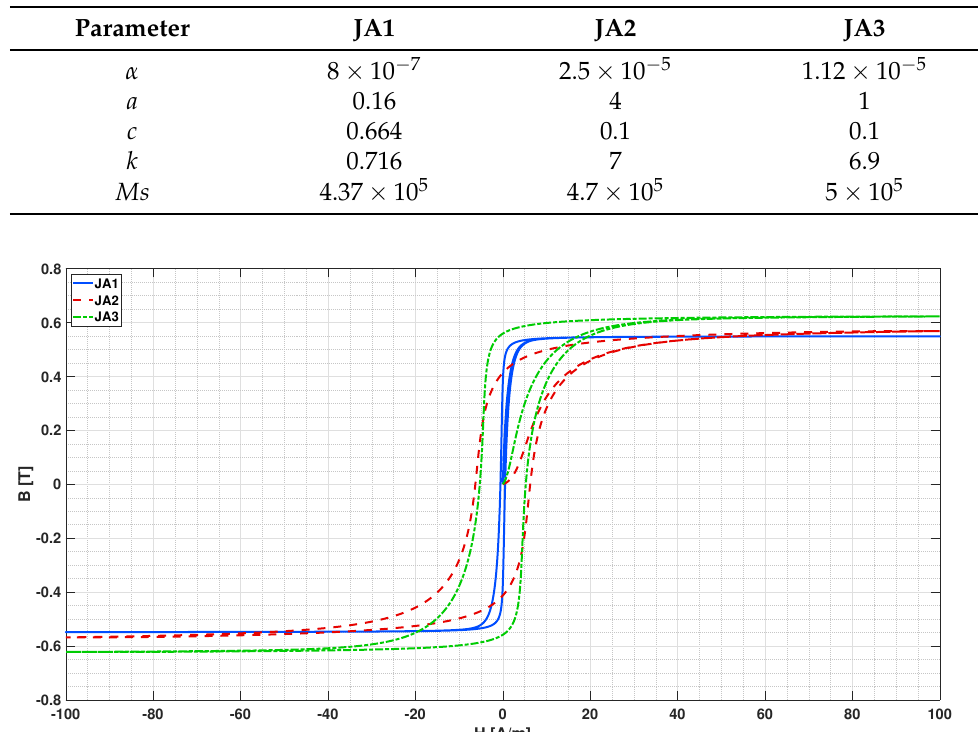
Figure 6. Comparison of the hysteresis loops reconstructed from the Jiles–Atherton parameters of fitted curves JA1 (continuous blue), JA2 (dashed red), and JA3 (dash-dotted green) reported in Table